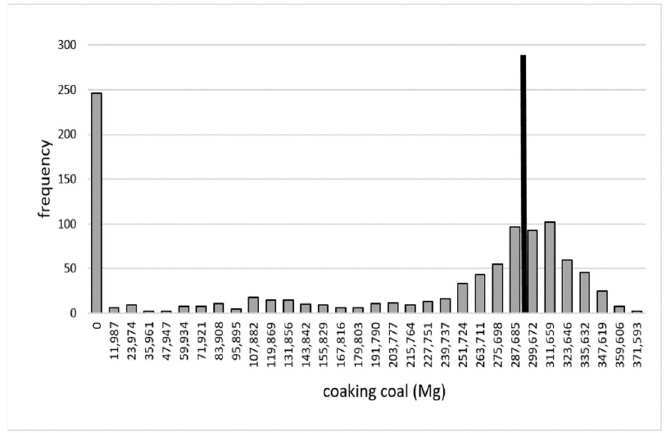
Figure A11. Histogram showing frequencies of achieving given quantity of sales of coking coal (“Export 2”) for mine “D” with σ yprog .